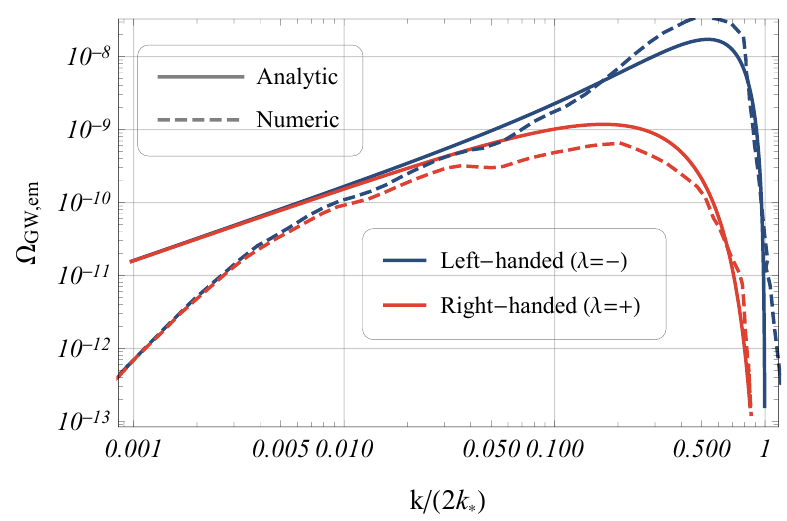
Figure 10 . Spectrum of the GW for both polarizations produced by dark photons. The solid curves show the analytic spectrum we obtained in eq. (3.28) while the dashed curves show the corresponding numerical results found in ref. [62]. The numeric data is extracted from figure 3 of ref. [62] where the parameters are α a = 55 , θ = 1 . 2 and f a = 10 17 GeV. This corresponds to φ os = θf a = 1 . 2 × 10 17 GeV and ϕ = α a θ = 66 . In extracting the numerical data we have re- scaled the horizontal axes such that the peak of the analytic and numeric spectra happens at the same k/ 2 k ∗ . The numerical value needed for a perfect match is k num = 1 . 8 mκ ∗ where κ ∗ is given ∗ in eq.